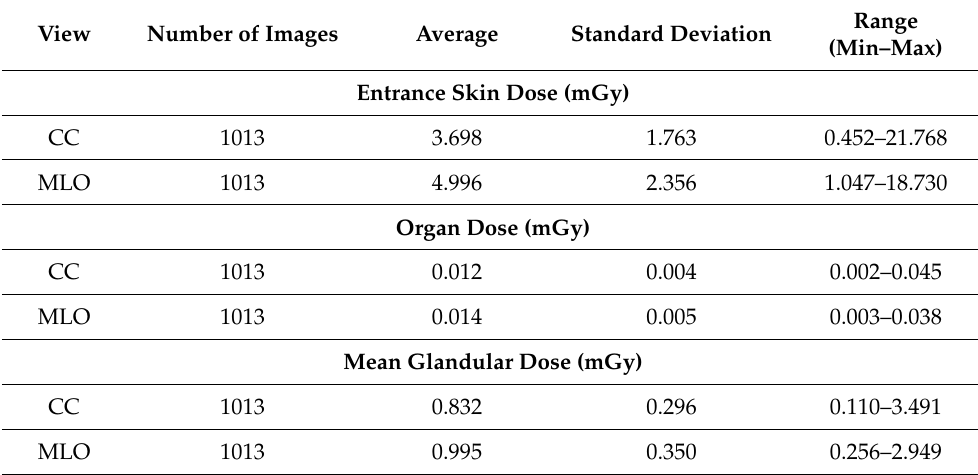
Table 1. Descriptive summary of entrance skin dose (ESD), organ dose (OD), and mean glandular dose (MGD) based on view.